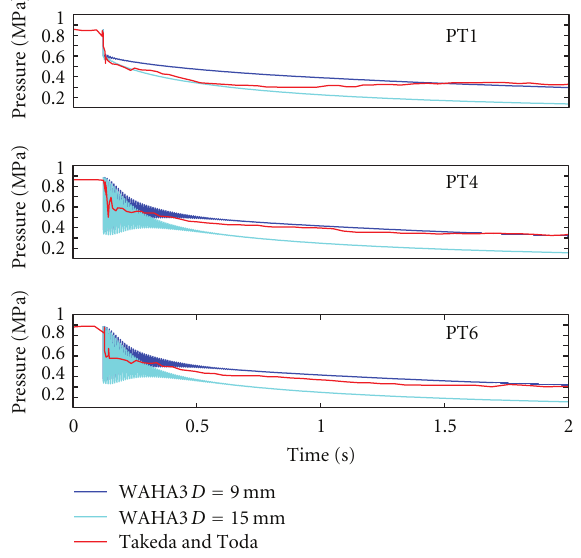
Figure 9: Time 2s pressure readings using 9 and 15 mm break